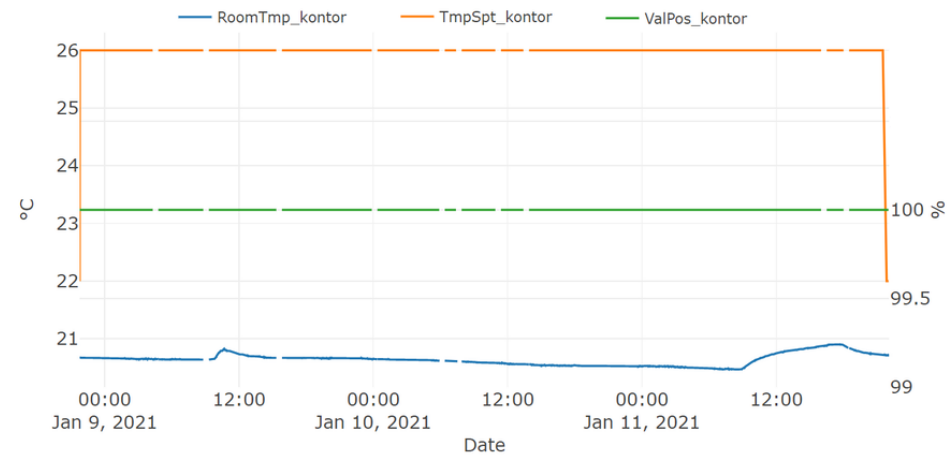
Figure 11. Time step response of the temperature setup: maximum temperature. During the two days test, the outside temperature changed between 0 and 5.5 ◦ C, as shown in Figure 12. It is also possible to see that the small peaks in the ambient temperature also provided a small increase in the indoor temperature of Figure 11.